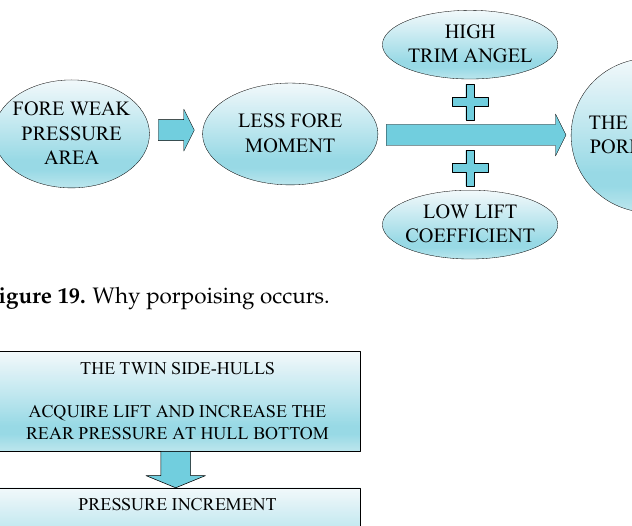
Figure 18. Forces and moment acted on the hull surface in the TFS.